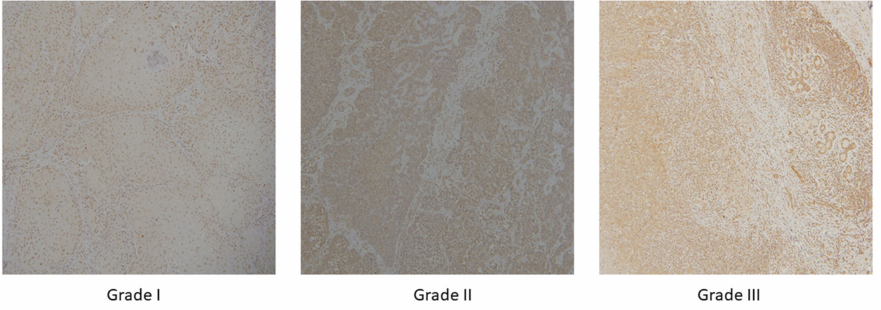
Figure 2. OSCC group of well-differentiated OSCC ( grade I ), moderately differentiated OSCC ( grade II ) and poorly differentiated OSCC ( grade III ) with magnification ×